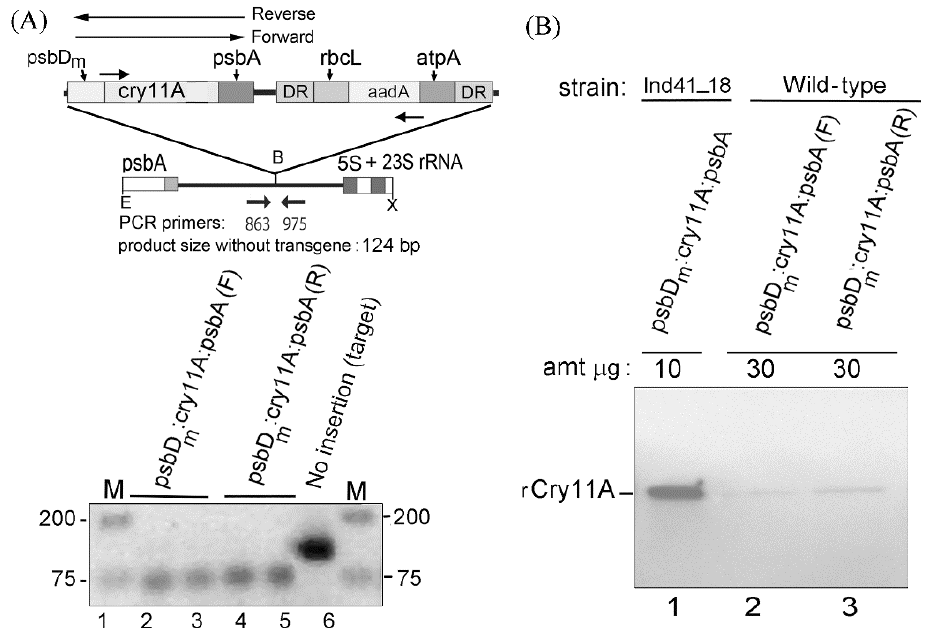
Figure 1. Transformation and expression of the psbD m :cry11A:psbA transgene in a wild-type C. rein- hardtii strain (CC-1690). ( A ) Transforming DNA and test of homoplasmicity by PCR. ( Above ) The diagram is of the introduced DNA (top, expanded), and the site of integration in the chloroplast genome at the BamHI site. The selectable marker gene is atpA:aadA:rbcL, and it is flanked by a direct repeat (DR) that allows for loss of the marker gene by recombination, though that was not sought in this case. The location of the PCR primers used to check for homoplasmicity, and the predicted product size (124 bp) if there are no transgenes, is shown. E, B, X are restriction sites EcoRI, BamHI, and XbaI, respectively. ( Below ) PCR analysis of four transformants (lanes 2 – 5) and the recipient strain (lane 6); two of the transformants contained the psbD m :cry11A:psbA transgene in the forward orientation (lanes 2 – 3) and two had it in the reverse orientation (lanes 4 – 5). Lanes 1 and 7 contained DNA markers (M). The photograph is of the ethidium-DNA fluorescence gel, and the image was inverted. ( B ) Western blot analysis of psbD m :cry11A:psbA transformants, one in each orientation. In total, 30 µg of total protein was loaded for each of the psbD m :cry11A:psbA transformants (lanes 2 – 3), but only 10 µg of total protein was loaded for the Ind41_18/ psbD m :cry11A:psbA strain grown under inducing conditions (lane 1). The blot was probed with the enzyme-conjugated anti-Flag tag mono- clonal antibody.